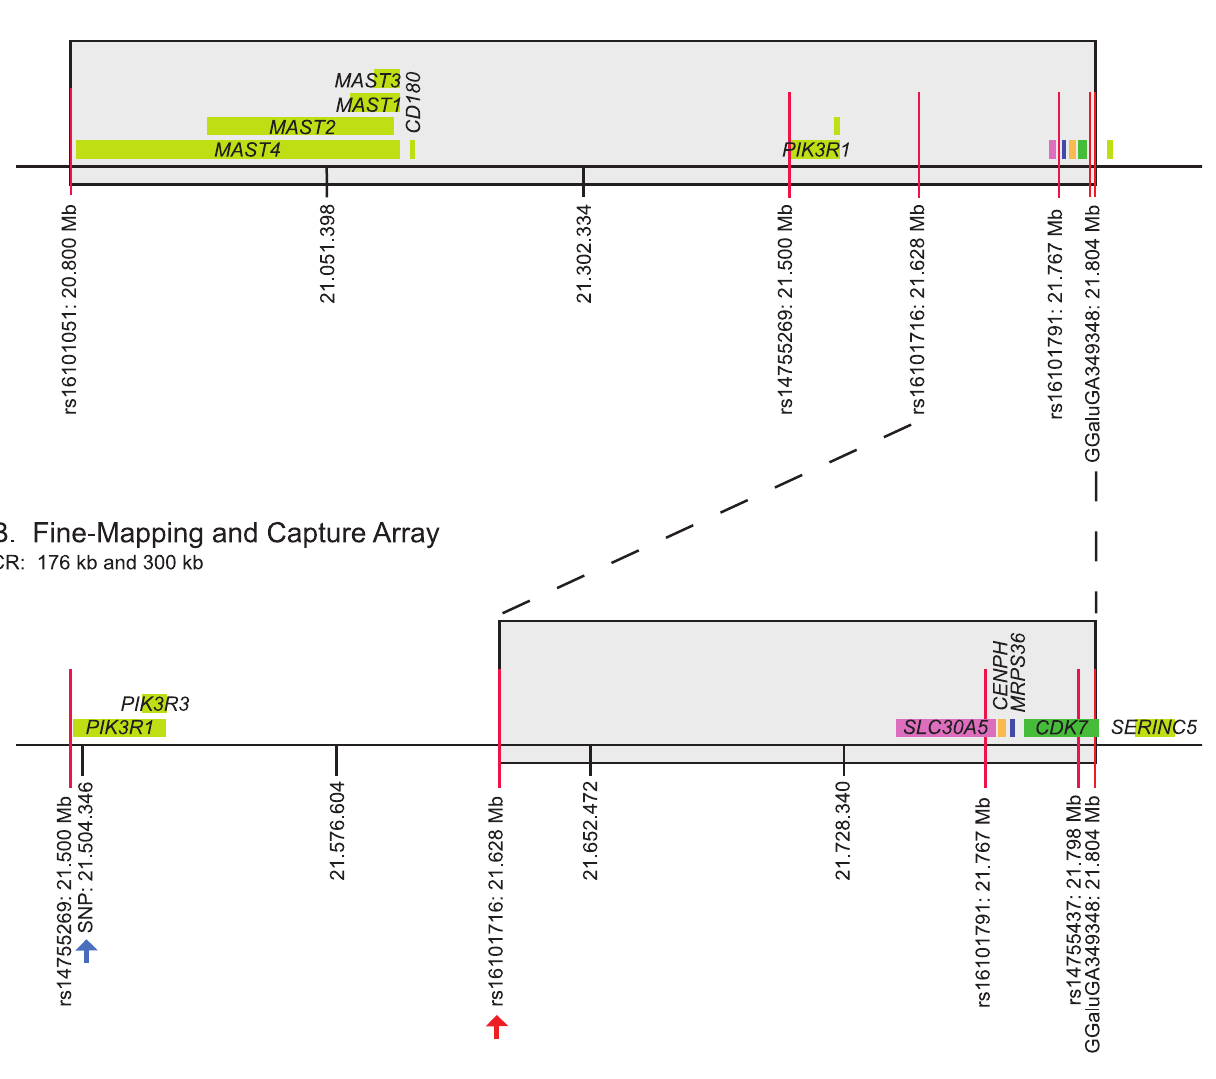
Figure 2. Schematic of causative region size reduction using three technologies. A. Coloboma Z chromosome causative region (CR) identified by the 60 K SNP array: Six polymorphic SNP markers (red lines) mark the 1.004 Mb causative region (CR min ) identified by utilization of the Illumina 60 K chicken iSelect SNP genotyping array [4]. SNP markers rs16101051 and GGaluGA349348 denote the boundaries of this region (GGA Z: 20,800,461-21,804,207). Eleven genes (predicted and confirmed) reside within the original 1.004 Mb region (indicated by the gray box). Chromosomal coordinate (bp) on GGA Z are based on the November 2011 Gallus gallus assembly (galGal4). B. Coloboma causative region identified by fine-mapping and analysis of the capture array data: Fine-mapping reduced the causative region to 175,915 bp (aka 176 kb). The following SNP markers designate the boundaries of this region: rs16101716 (red arrow) and GGaluGA349348 (GGA Z: 21,628,290–21,804,207). The 176 kb causative region contains 4 known chicken genes (pink box: SLC30A5 ; orange box: CENPH ; blue box: MRPS26 ; green box: CDK7 ). Prior to fine-mapping and subsequent reduction to 176 kb, the use of the CA/NGS technology, specifically analysis of sample co-275 sequence data, allowed for a region reduction to 299,860 bp (this boundary is denoted with a blue arrow). Chromosomal coordinate (bp) on GGA Z are based on the November 2011 Gallus gallus assembly